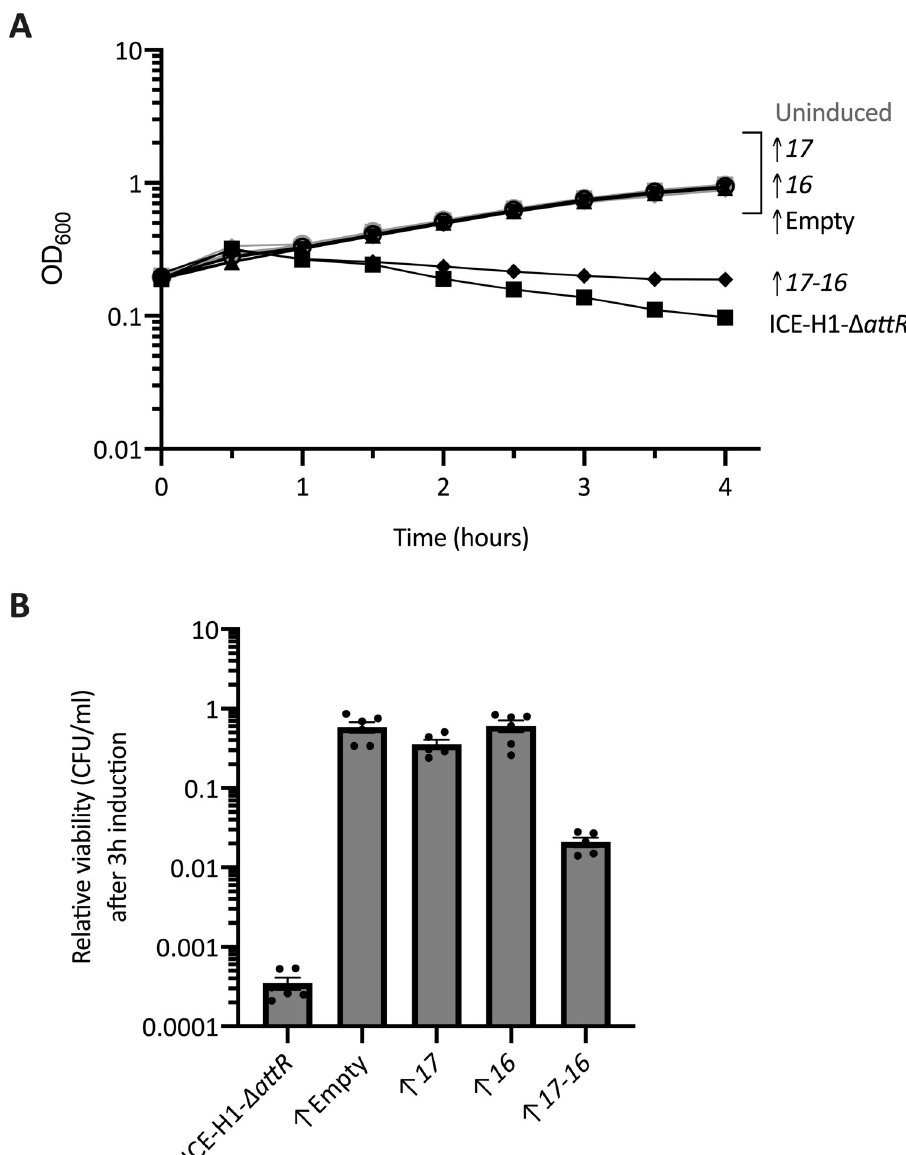
Fig 4. Orf17-16 are sufficient to cause arrest of cell growth. Strains containing overexpression alleles (indicated in the figure with an upwards arrow) of orf17 (downward triangle, ELC1494), orf16 (upward triangle, ELC1491), orf17 - 16 (diamonds, ELC1496), or an empty vector (open circles, ELC1495) and a strain containing ICE-H1- Δ attR (Rep-) (squares, ELC1076) were grown in minimal medium with arabinose to early exponential phase. At an OD 600 of ~0.2 (time = 0), cultures were split into inducing (+1% xylose to stimulate rapI expression) and non-inducing conditions. Data from three or more experiments are presented as averages ( A ) or individual data points ( B ), and error bars represent standard error of the mean. A) Growth was monitored by OD 600 for three hours. Black lines indicate growth of the induced cultures; gray lines (difficult to see as they are clustered in the set of strains at the top of the graph) indicate growth of uninduced cultures. The growth curve of ELC1076 {containing ICE-H1- Δ attR (Rep-)} from Fig 3A is included as reference. Error bars could not always be depicted due to the size of each data point. B) The relative CFUs/ml of cultures after three hours of element induction was calculated as the number of CFUs formed by the induced culture, divided by that from the uninduced culture (a value of “1” indicates there is no change in CFUs with induction). Results from the overexpression of orf17 - orf16 were significantly different from the empty vector control based on P < 0.05 in unpaired two-tailed